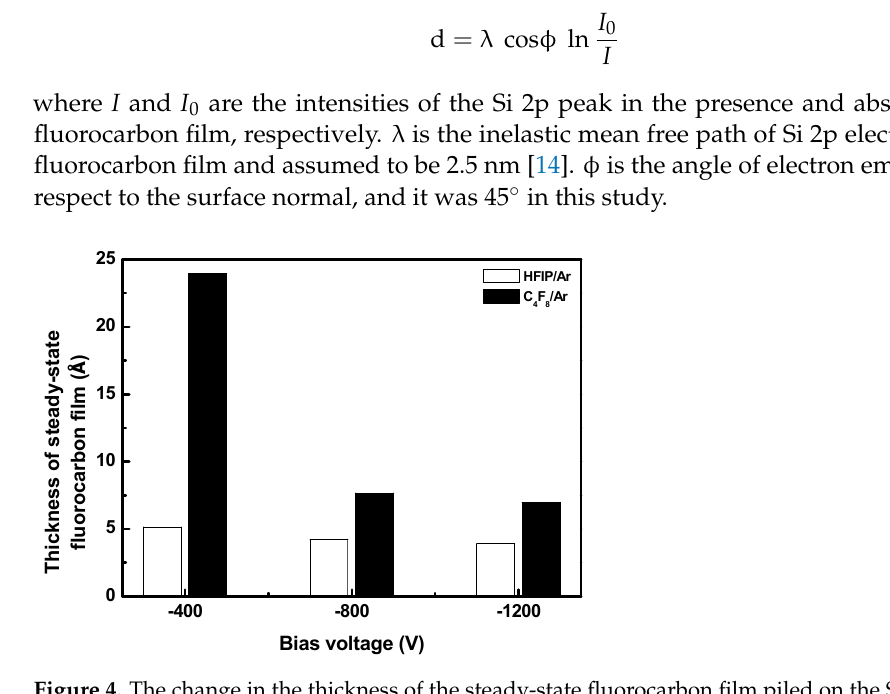
Figure 4. The change in the thickness of the steady-state fluorocarbon film piled on the SiO 2 surfaces in HFIP/Ar and C 4 F 8 /Ar plasmas at various bias voltages.